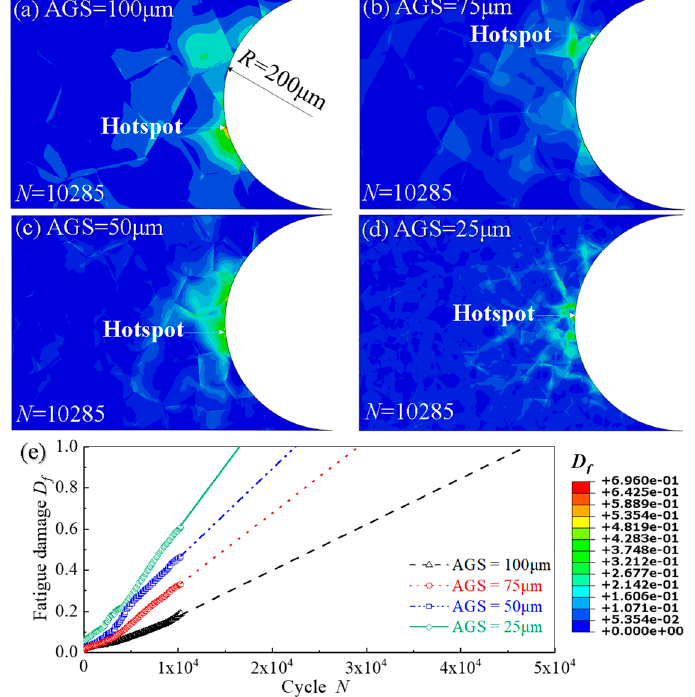
Figure 11. Distribution of fatigue damage of notch specimens with different AGSs:( a ) 25 μ m; ( b ) 50 μ m; ( c ) 75 μ m; ( d ) 100 μ m and ( e ) the evolution curves of fatigue damage D f of hotspots from ( a – d ).